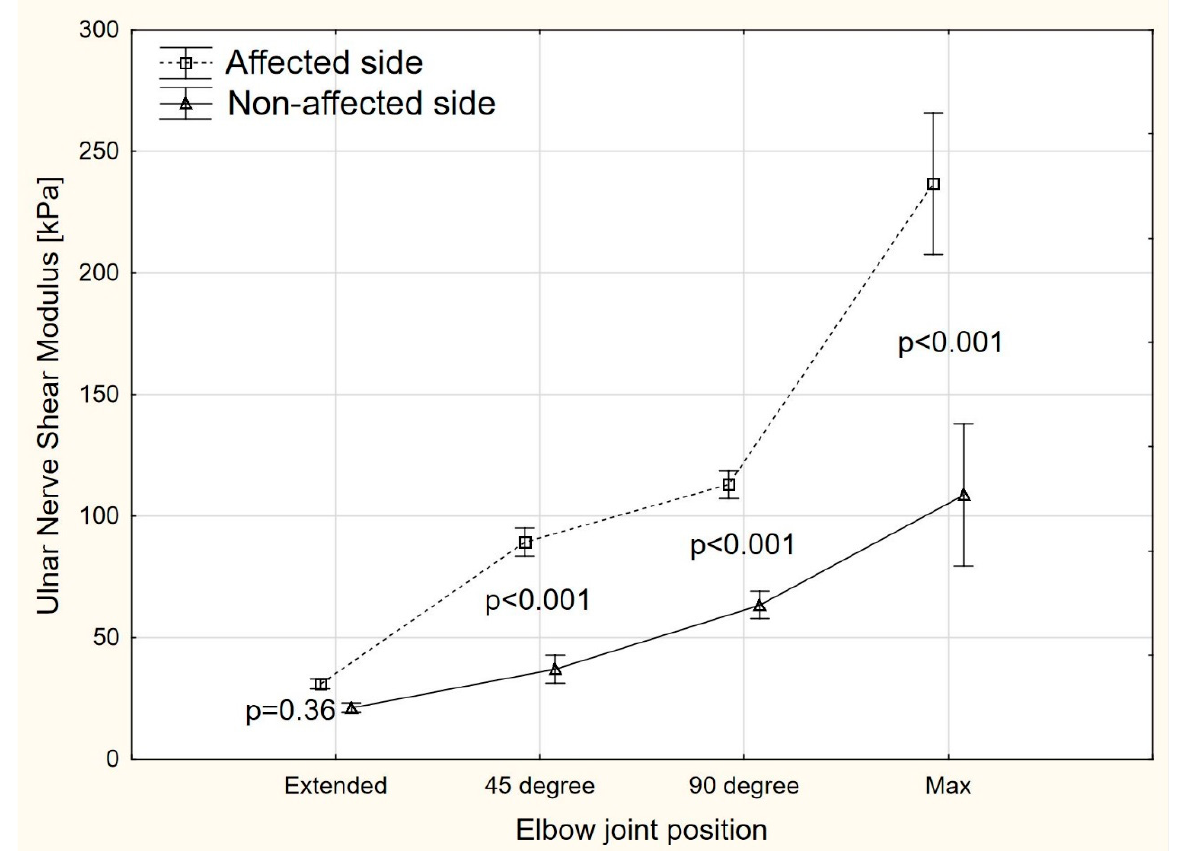
Figure 3. The share modulus changes in different positions of the elbow joint.